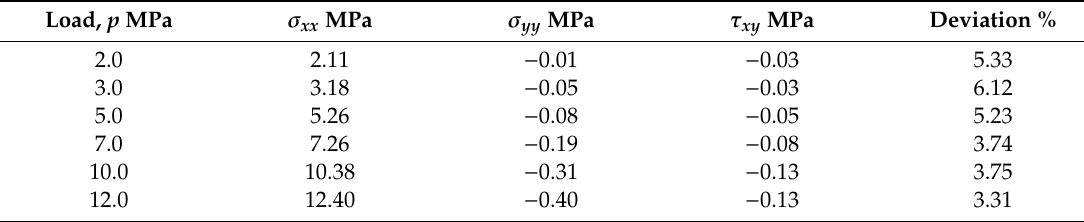
Table 1. Comparison between applied load and calculated